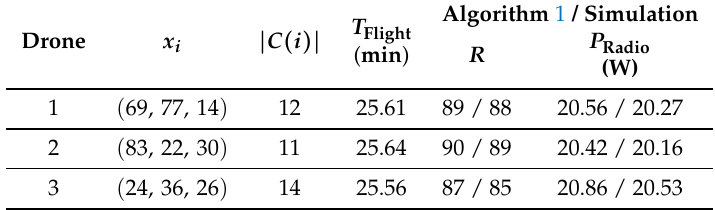
Figure 4. Example solution. Table 4. Algorithmic and simulation